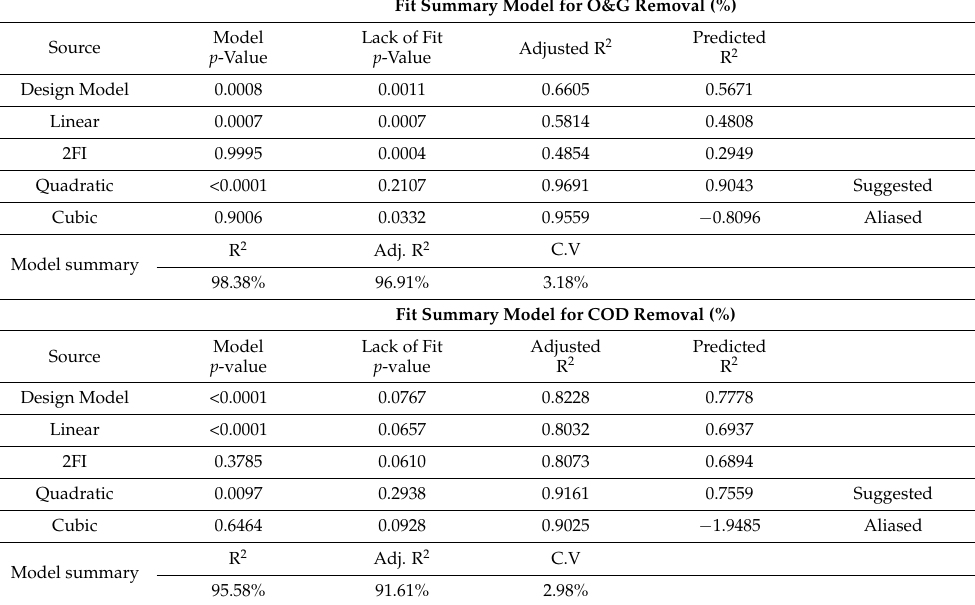
Table 5. Fit summary